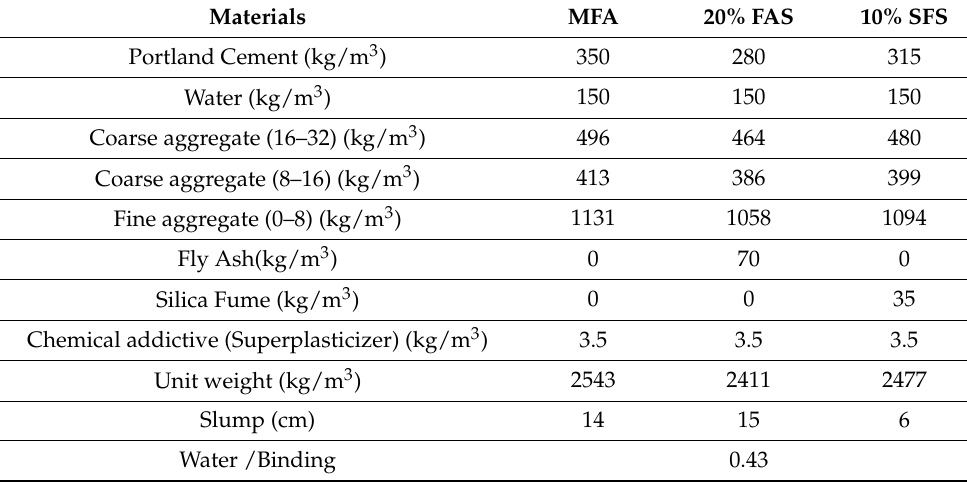
Table 5. 1 m 3 concrete admixture values and fresh concrete contents.